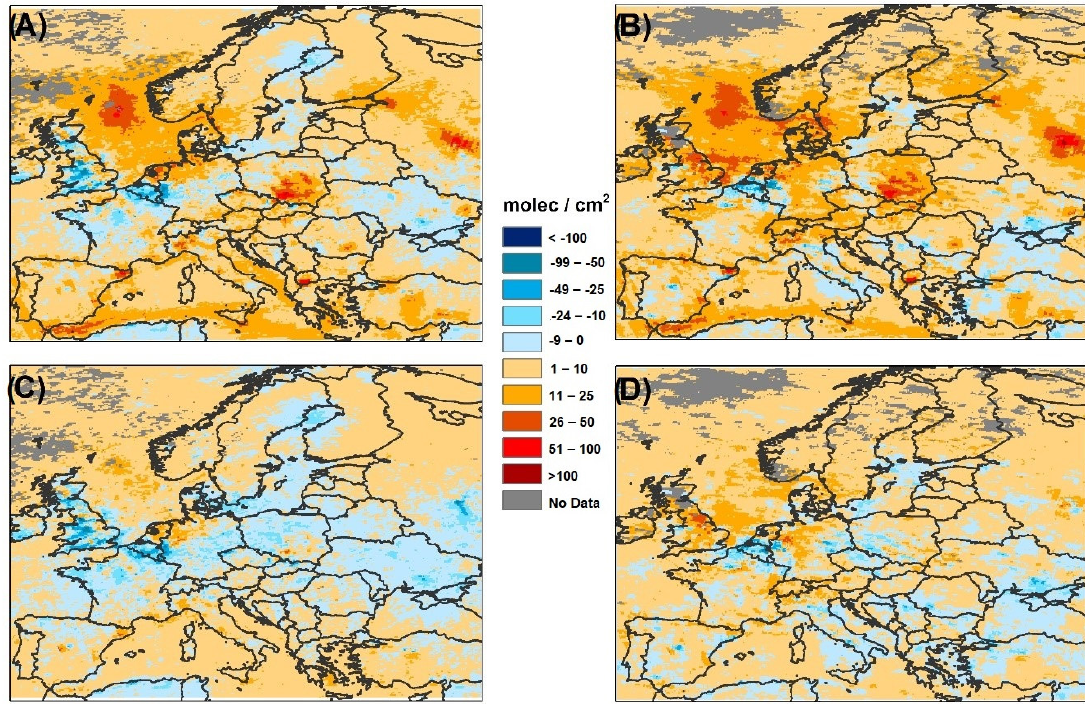
Figure 7. Differences (10 15 molec/cm 2 ) in the tropospheric NO 2 columns derived from GEM-AQ for the baseline emissions (upper row) and the modified emissions (bottom row) and satellite observations (OMI left, right SCIAMACHY) for June 2011.